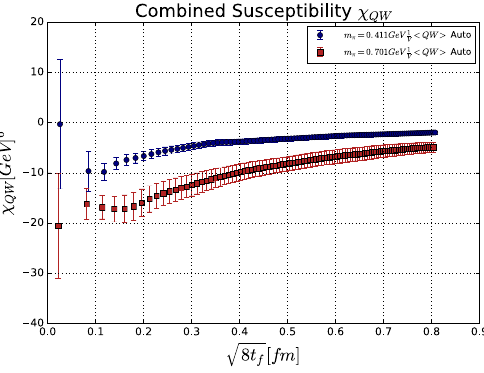
Q in GeV 6 against the flow-time radius (cid:31) O W (cid:29)